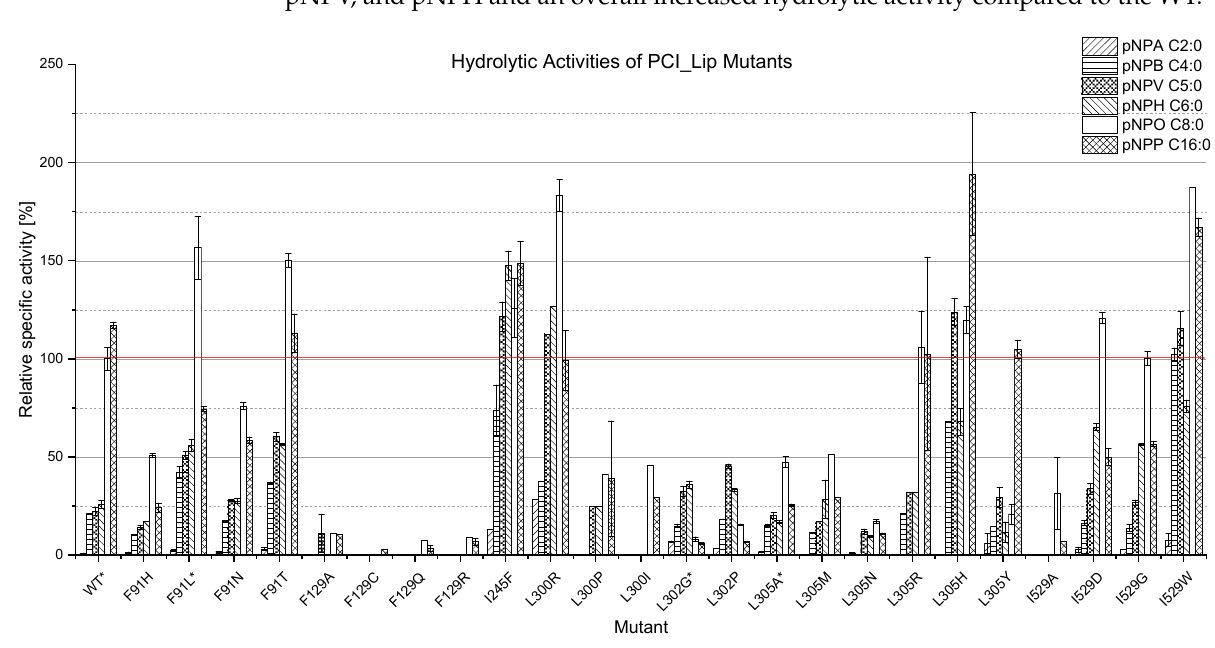
Figure 1. Relative specific activity [%] of PCI_Lip mutants (expression: n = 1, mutants marked with * n = 3) against selected model substrates. The relative specific activities were based on the specific activity [U mg − 1 ] of the PCI_Lip WT against pNPO (set to 100%, red line). The photometric esterase/lipase assays were performed in triplicates. The error bars represent the standard deviation of these measurements.